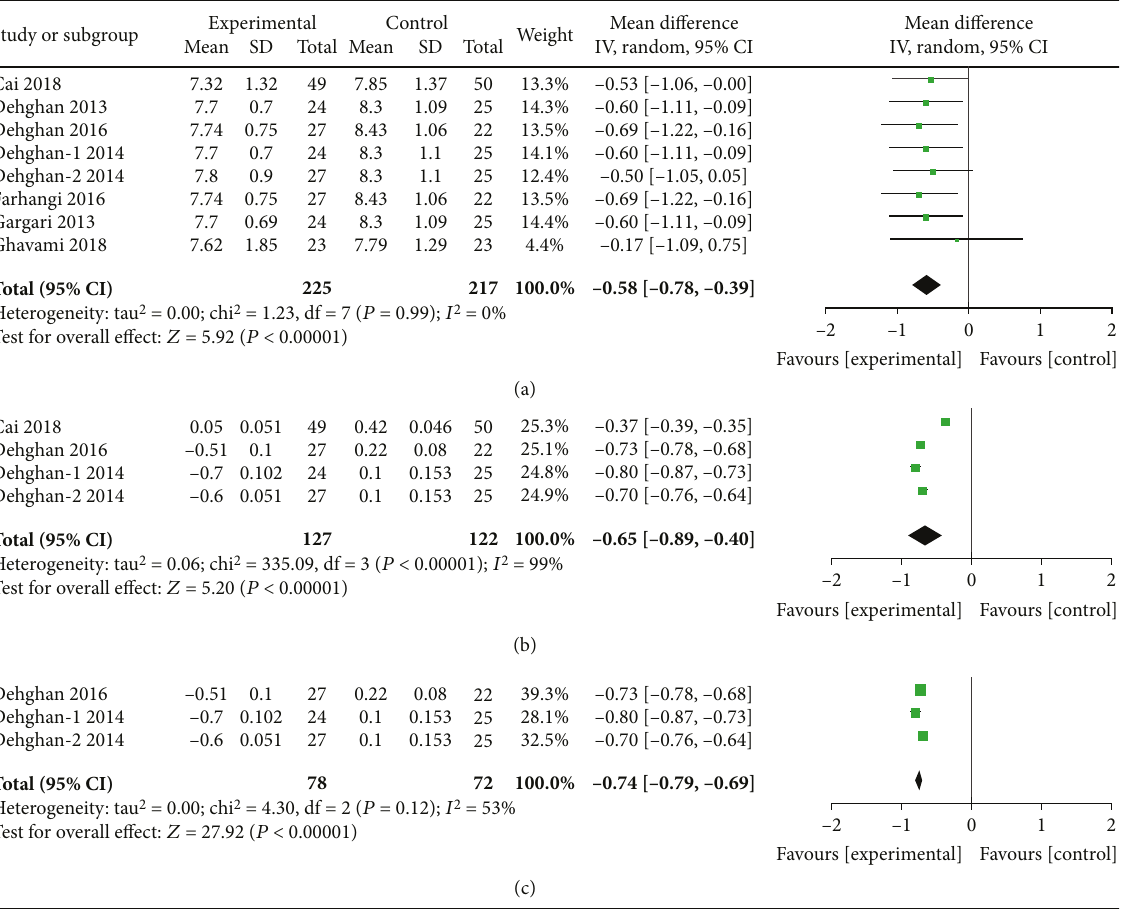
Figure 6: Findings of a meta-analysis of studies with continuation data on amelioration in HbA1c for ITC vs. control groups, with estimated MD and 95% CI. (a) Postintervention data of HbA1c, (b) reduction data of HbA1c, and (c) subgroup analysis for reduction data according to the baseline BMI